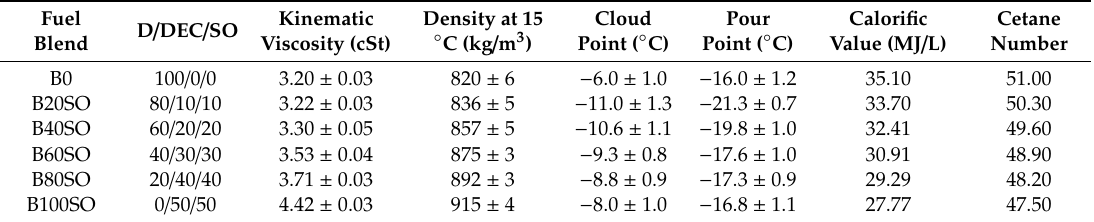
Table 4. Fuel properties of diesel (B0), DEC / SO double blend (B100) and D / DEC / SO triple blends (B20-B80), containing 50% DEC. Experimental data are showed along with the standard deviation obtained from average of three measurement.